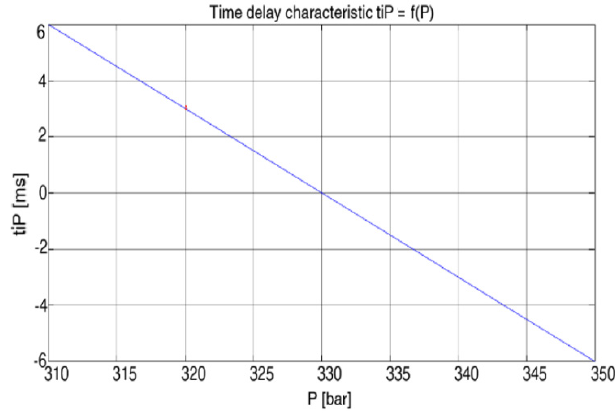
Figure 14. Time delay characteristic of the oil pressure on the disconnection of a circuit breaker.